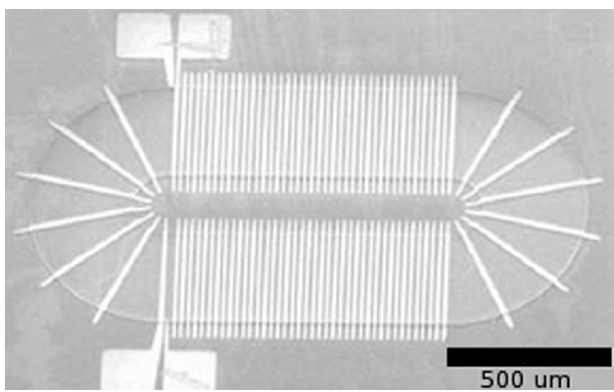
FIG. 2. Scanning electron micrograph of a surface- micromachined racetrack transformer fabricated at UCLA.